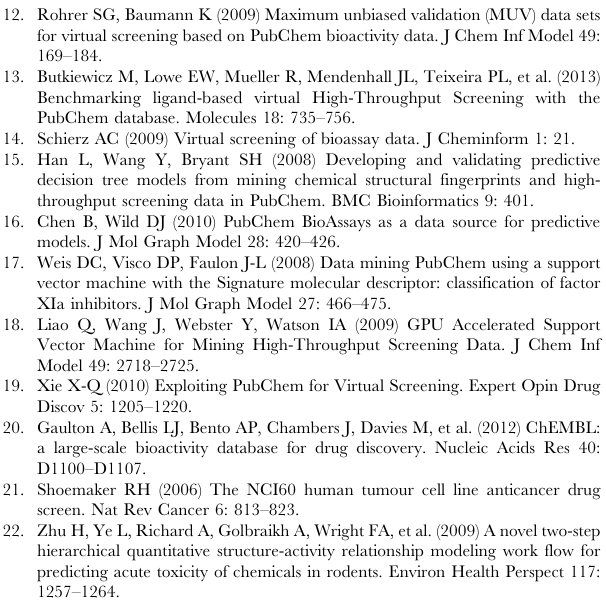
Table S2 The top-ranked 47 PubChem bioassays. Table S3 The top 32 new PubChem compounds ranked by S score. The compounds were prioritized using assay profiles which consists of 47 bioassays. Their toxicity excerpts were also listed. Protocol S1 The Perl scripts used in this